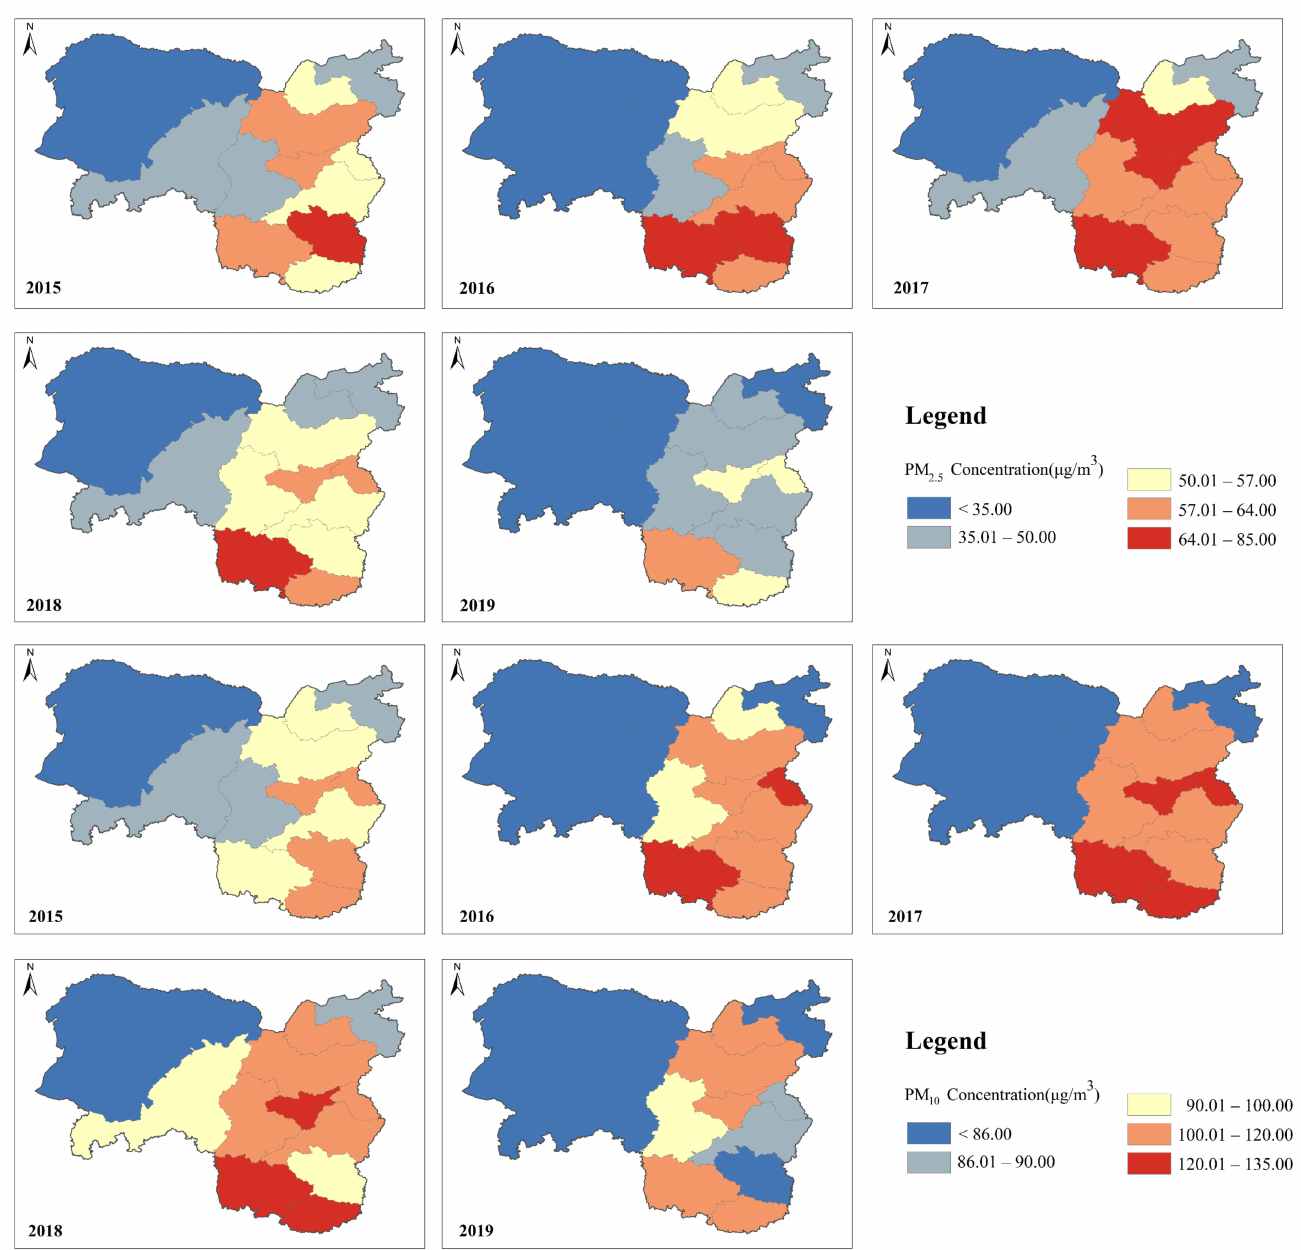
Figure 4. Spatial distribution of PM 2.5 and PM 10 in the study area from 2015 to